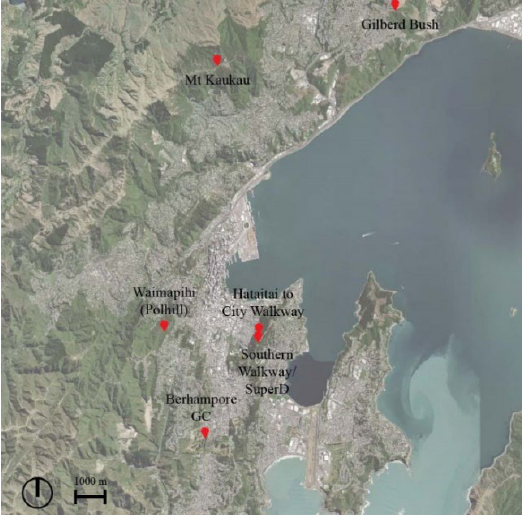
Figure 2. Pedestrian and cyclist counter locations in Wellington green spaces. Berhampore Golf Course (GC) and Mount Kaukau had pedestrian-only counters. The other four locations had MULTI counters. The base satellite image is from Landcare Research [37].